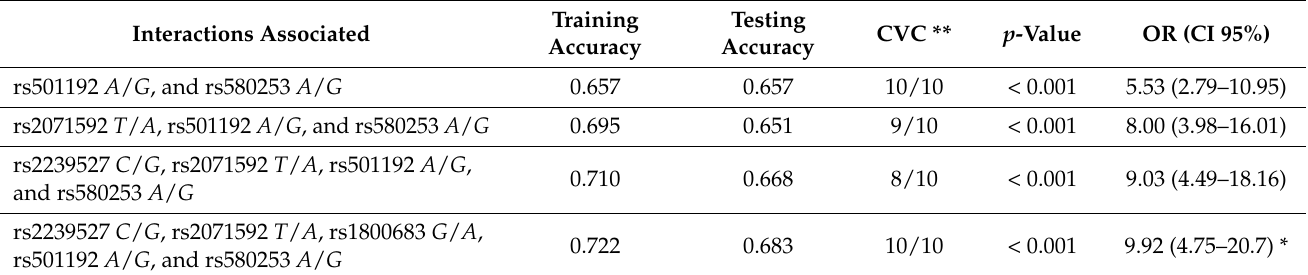
Table 5. Gene–gene interactions between BAT1 rs2239527 C / G , NFKBIL1 rs2071592 T / A , LTA rs1800683 G / A , CASP1 rs501192 A / G , and CASP1 rs580253 A / G polymorphisms in patients